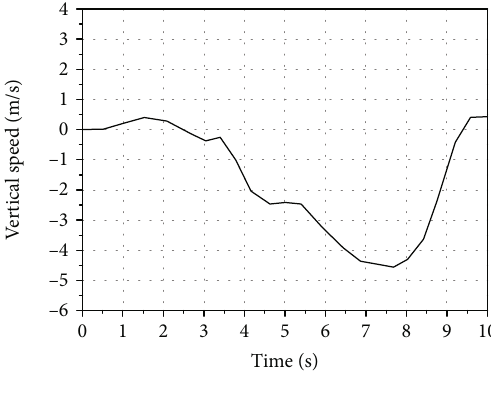
Figure 4: Aircraft longitudinal speed.